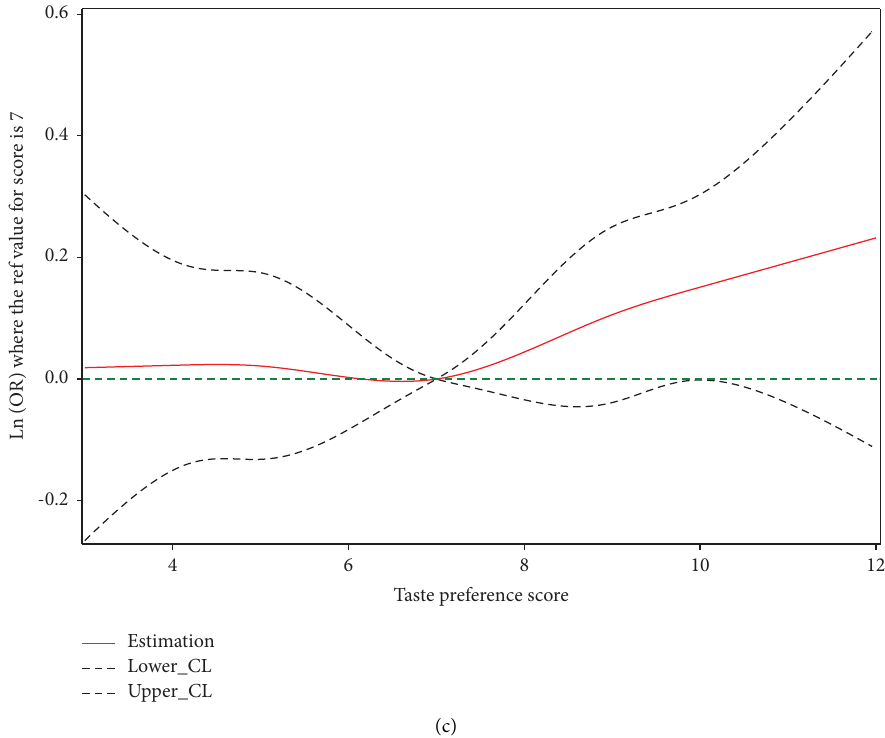
Figure 2: Te restricted cubic spline for the taste preference score and hypertension risk, stratifed by sex. Curves were ftted as a smooth term using a restricted cubic spline with 5 knots (5%, 25%, 50%, 75%, and 95%). Te reference value was the median taste preference score. (a) Te restricted cubic spline of the taste preference score and hypertension risk in all populations. (b) Te restricted cubic spline of the taste preference score and hypertension risk in females. (c) Te restricted cubic spline of the taste preference score and hypertension risk in